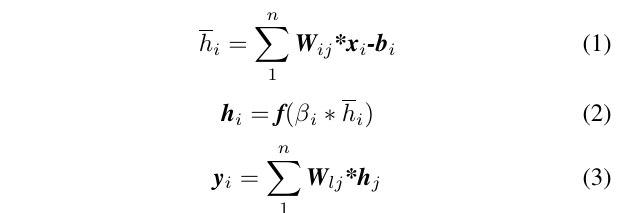
In Figure. 1, { x i ,y i } represents input and output layer units in this traditional model. For this type of feed-forward network, formulas between these three layers are shown